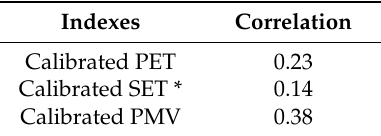
Table 9. Correlation between the PET, SET * and PMV models calibrated by Gobo, Galvani and Wollmann (2018) for Santa Maria and the thermal preference of the